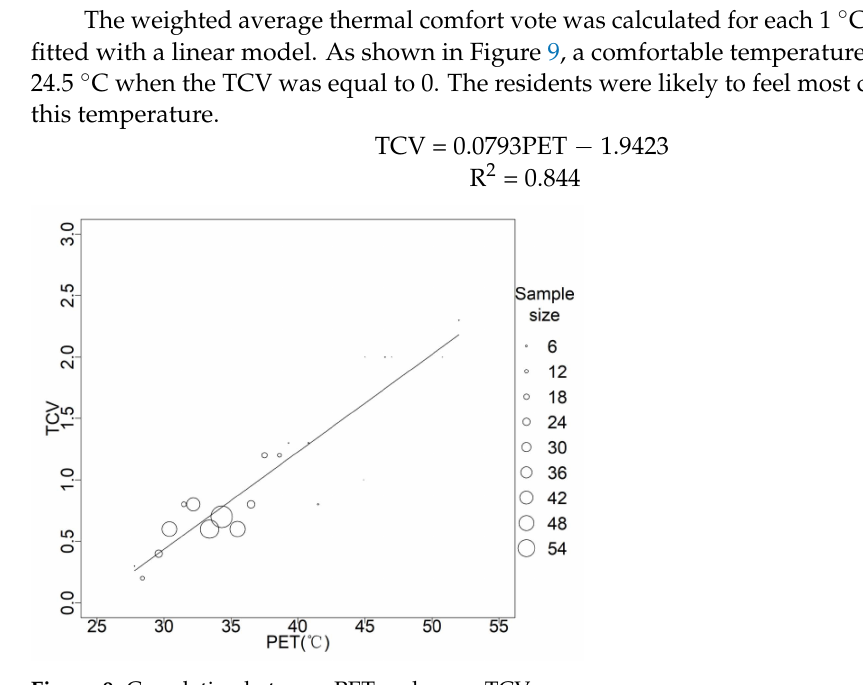
Figure 9. Correlation between PET and mean